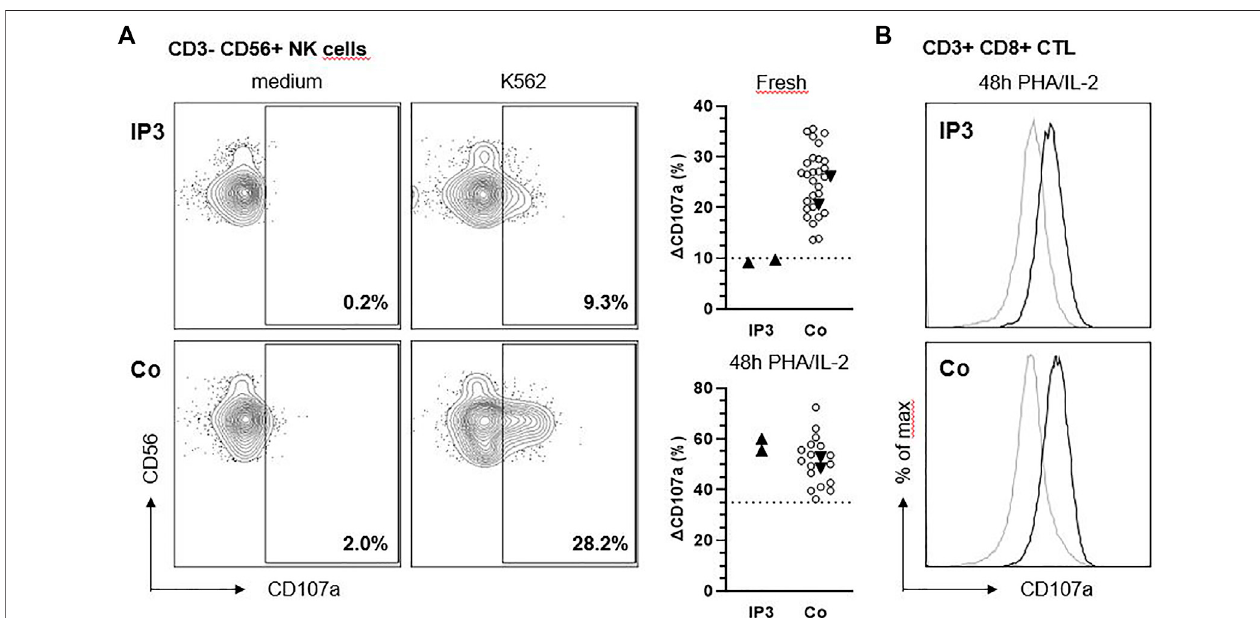
FIGURE 3 | NK cell degranulation of IP3 is slightly reduced in response to K562. (A) Ex vivo degranulation of CD3 − CD56 + NK cells from IP3 and a healthy day control (Co.) after incubation with medium (left panel) or NK-sensitive K562 target cells (middle panel) assessed by fl ow cytometric analysis of CD107a surface expression.Graphs intheright panel show Δ CD107a forthe patientand healthyday controls (solid triangles) pooledfrom twoindependent experiments assessing fresh and activated (PHA/IL-2 pre-culture for 48 h) NK cell degranulation. Δ CD107a was calculated as the percentage of NK cells expressing CD107a after stimulation with K562 minus the percentage of NK cells expressing CD107a after incubation with medium. Blank circles represent historical controls ( n (cid:1) 28,17). The dashed line indicatesthediagnosticcutoffbelowwhichNKcelldegranulation isconsidered abnormalandequalsthe10thpercentileofareferencerange. (B) DegranulationofCD3 + CD8 + CTL after incubation with medium (grey line) or anti-CD3/CD28 beads (black